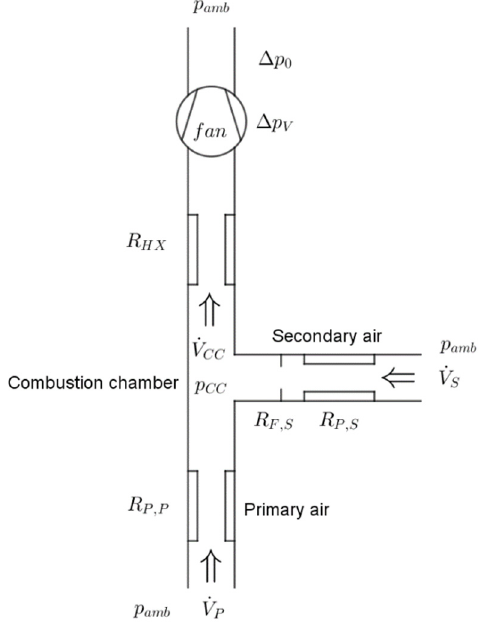
Figure 3. Scheme of air mass flow with fan and division into primary air and secondary air.